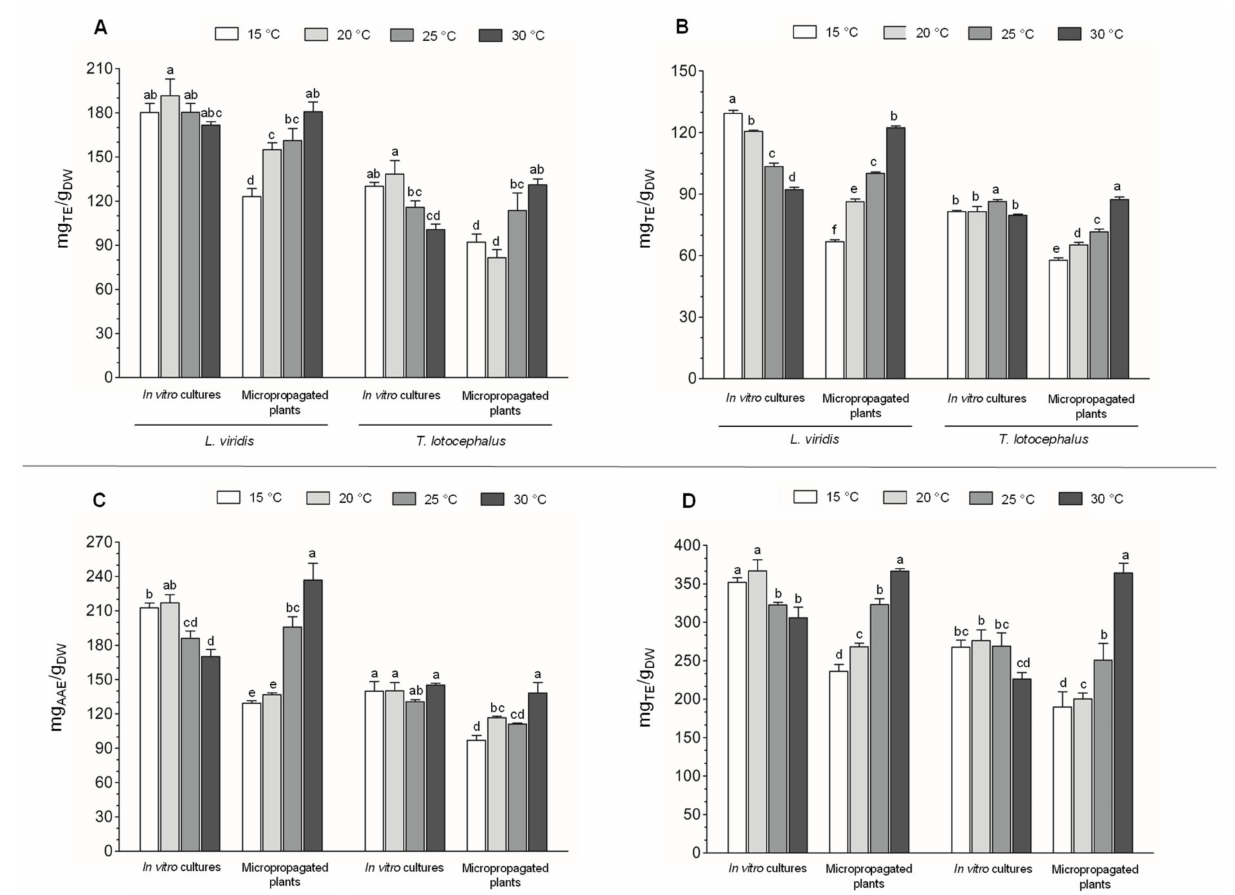
Figure 4. Antioxidant activity evaluated by ( A ) 2,2-diphenyl-1- picrylhydrazyl (DPPH), ( B ) 2,2- azino-bis (3-ethylbenzothiazoline-6-sulfonic acid) (ABTS), ( C ) ferric reducing antioxidant power (FRAP), and ( D ) oxygen radical absorbance capacity (ORAC) methods of the extracts from in vitro cultures and micropropagated plants of Lavandula viridis and Thymus lotocephalus exposed to different temperatures (15, 20, 25, and 30 ◦ C). For each species, the results were analyzed by one-way analysis of variance (ANOVA) and the graph bars followed by different letters (a–f) are significantly different at p < 0.05 (Duncan’s New Multiple Range